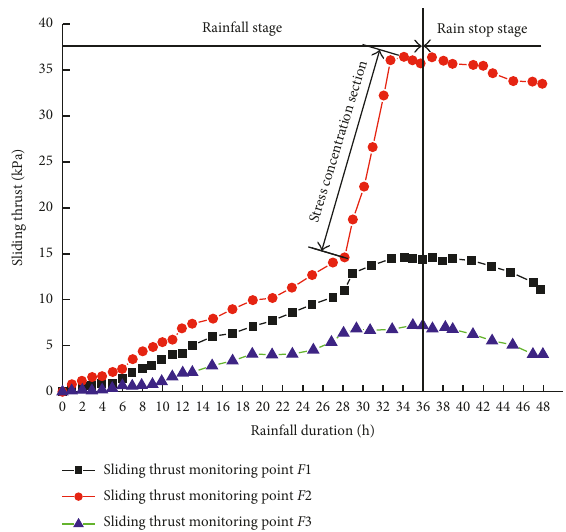
Figure 8: Variation law of sliding thrust under long-time heavy rain.